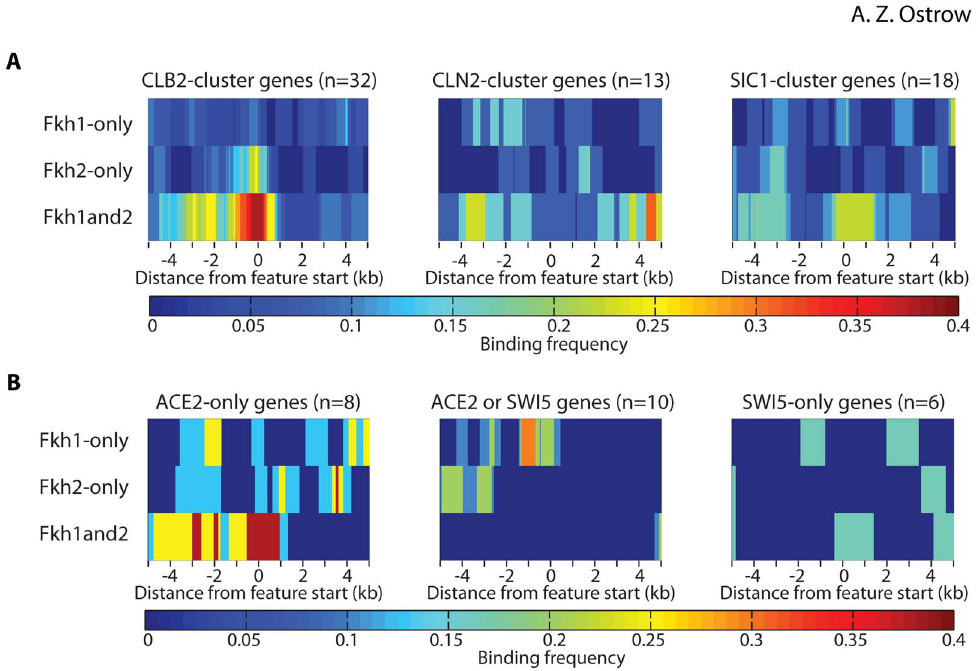
Figure 4. Fkh1 and Fkh2 binding with target genes. Heat maps show 10 kb regions of summed binding data for the indicated types of binding loci (Fkh1-only, Fkh2-only, Fkh1and2) surrounding the groups of features indicated above the heat map. The color represents the frequency of enriched binding sequences called for each group of features, amongst total number of features (n) included in each group. A ) Fkh1 and Fkh2 enrichment frequencies surrounding CLB2- , CLN2- , and SIC1 -cluster genes are plotted as separate groups, with the respective ORFs aligned by their start codons at coordinate 0, with transcription toward positive coordinates to the right. B ) Fkh1 and Fkh2 enrichment frequencies surrounding Ace2- only-regulated genes, Ace2- or Swi5-regulated genes, and Swi5-only-regulated genes are plotted with the ORFs aligned and oriented as in ( A